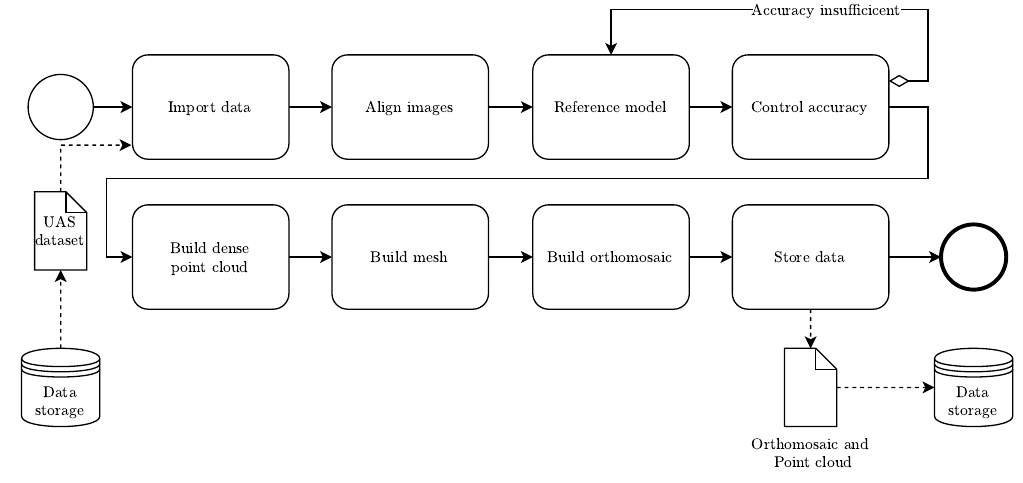
Figure 4. Data processing